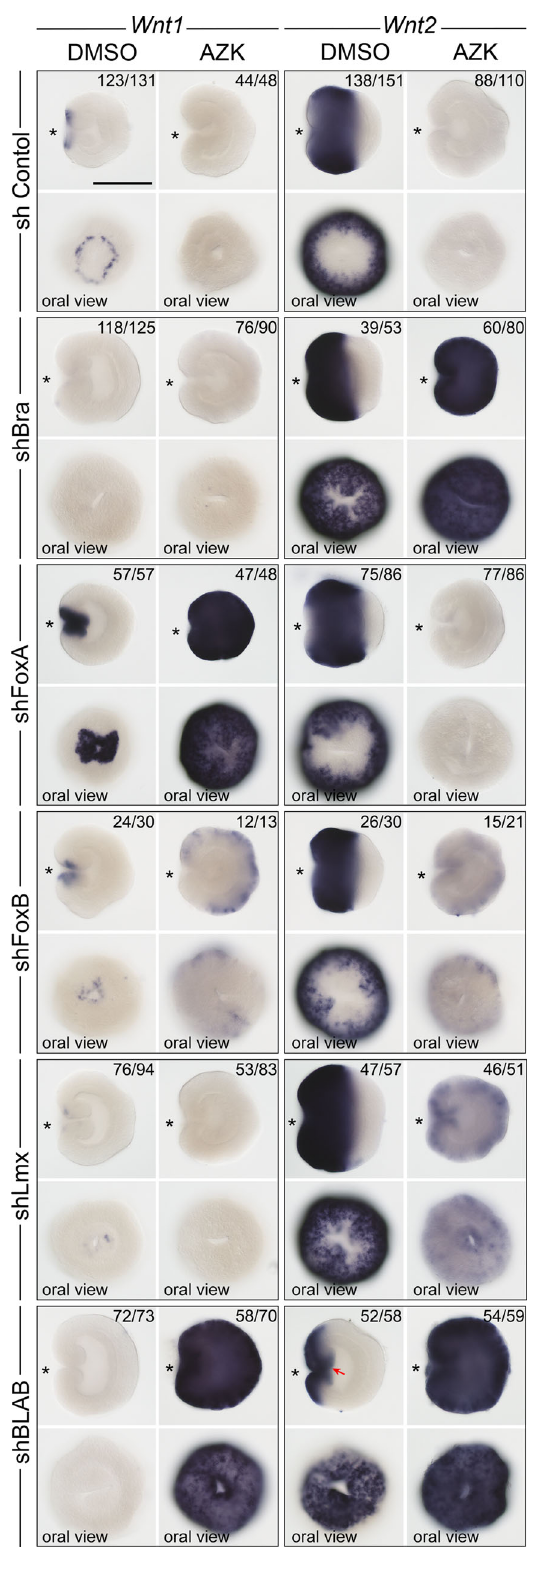
Fig. 3 The effect of the repressor X candidates knockdown on the expression of the “ window ” genes Wnt1 and Wnt2 . Bra and Lmx knockdowns convert Wnt2 into a “ saturating ” gene, while FoxA knockdown does the same with Wnt1 . The effect of Lmx knockdown appears to be similar but weaker than that of Bra . FoxB knockdown results in a “ weak AZK effect ” on both Wnt1 and Wnt2 suggesting that FoxB mildly represses both. The effects of the knockdowns of Bra , Lmx , and FoxB on Wnt2 expression are non-redundant, but similar and additive (see Supplementary Figs. 6 and 7). Quadruple knockdown with shRNA against Bra , Lmx , FoxA and FoxB ( = shBLAB) removes oral molecular identity of the embryo completely. Red arrow indicates the bottom of the pharynx expressing the midbody marker Wnt2 . On lateral views, asterisk denotes the blastopore. The numbers in the top right corner show the ratio of embryos displaying the phenotype shown on the image to the total number of embryos treated and stained as indicated on the fi gure. Scale bar 100